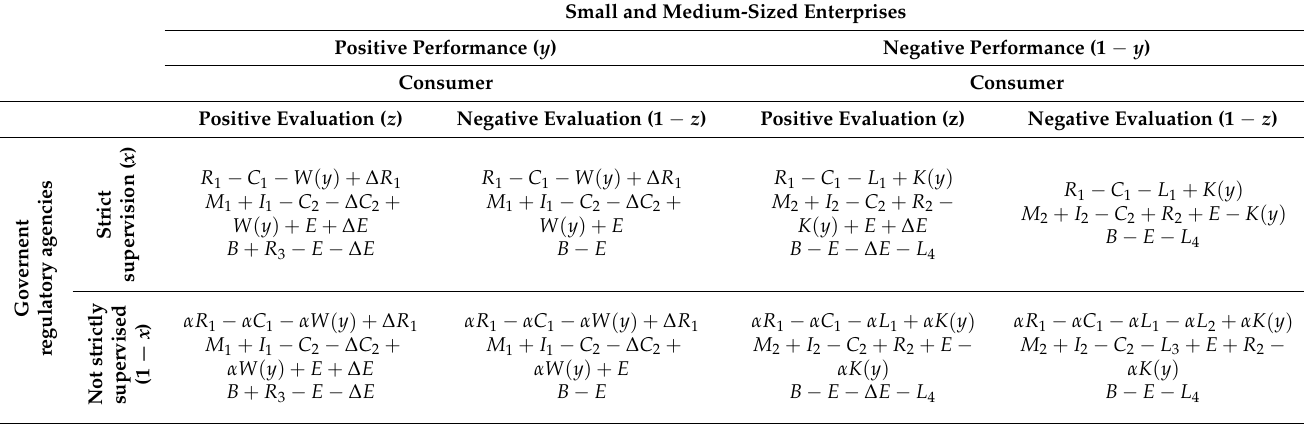
Table 1. Payment matrix of government regulatory agencies–SME-consumer game before public health emergencies. Small and Medium-Sized Enterprises Positive Performance ( y ) Negative Performance (1 − y ) Consumer